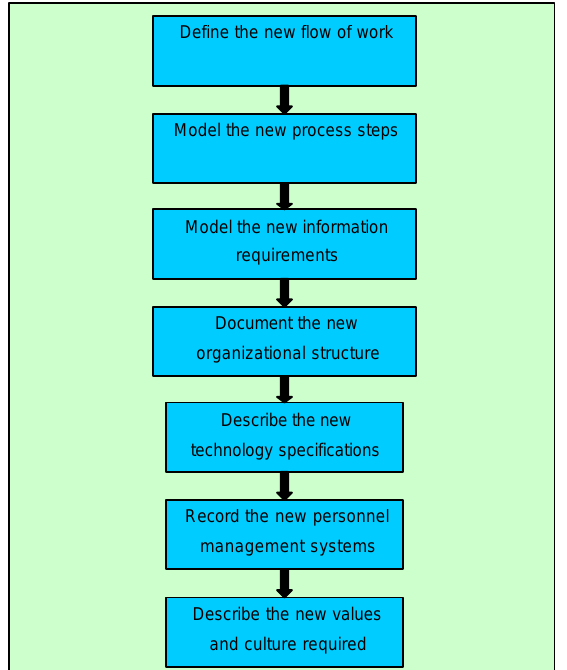
Figure 6: Activities Performed in Phase 6